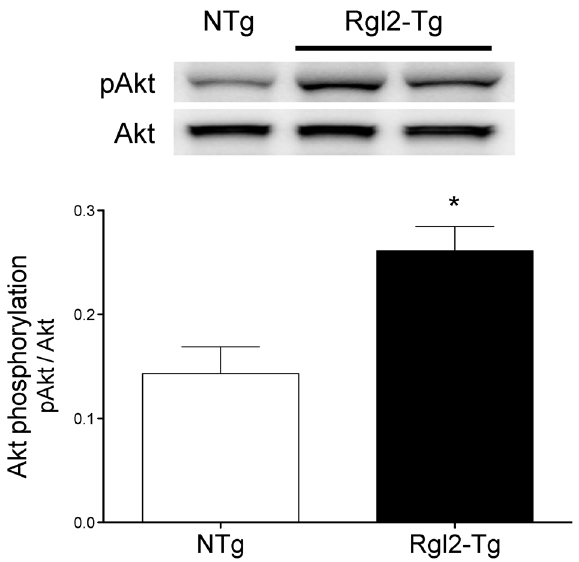
Figure 8. Effect of Rgl2 on the PI3K/Akt signaling pathway in transgenic mice. Heart homogenates prepared from Rgl2-Tg and NTg littermates were prepared and Akt phosphorylation quantified by immunoblotting with a phosphospecific Akt antibody and normalizing to total Akt. Shown are a representative immunoblot and the mean 6 SEM of 12 different homogenates. * denotes significant difference from NTg.